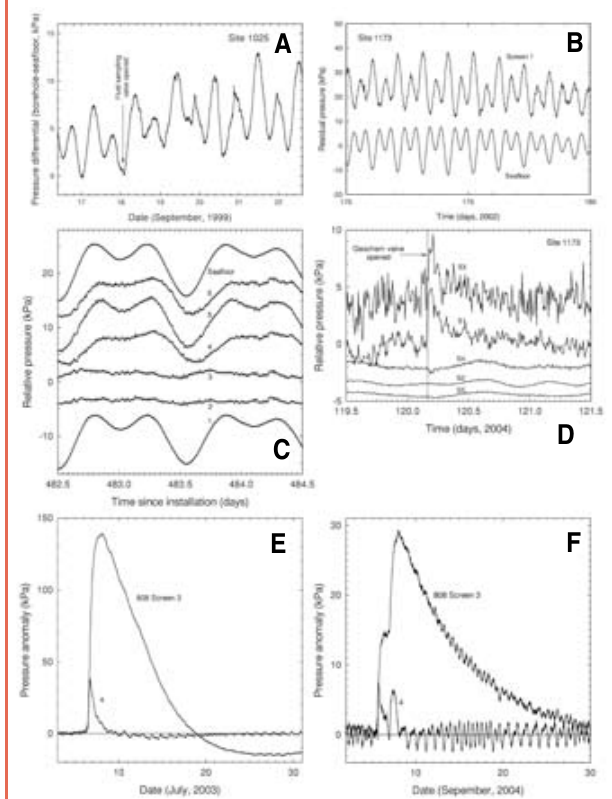
Figure 6. Indirect consequences of CORK-system leakage resulting from buoyancy [A] or thermal expansion effects (B–F) in high and low-permeability formations, respectively. [AF] Pressure before and after the opening of a fluid sampling valve at ocean crustal Site 1025. [B] Seafloor and formation pressures at Site 1173. During this time, the monitoring line to screen 1 was closed, but others were opened, allowing flow and thermal perturbations within the hydraulic umbilical. [C] Enigmatic tidal signals and coherent noise at Site 808 associated with flow inside the unsealed casing. [D] “Cross-talk” at Site 1173 when a geochemical sampling line leading to screen 4 was opened. [E] Transients recorded at Site 808 during fault-slip events in 2003 off Cape Muroto and [F] in 2004 off the Kii peninsula, Japan. Parts of the initial rises are the direct consequence of strain, but most of the signals are indirect thermal consequences of water expelled up the inside of the unsealed casing during the strain